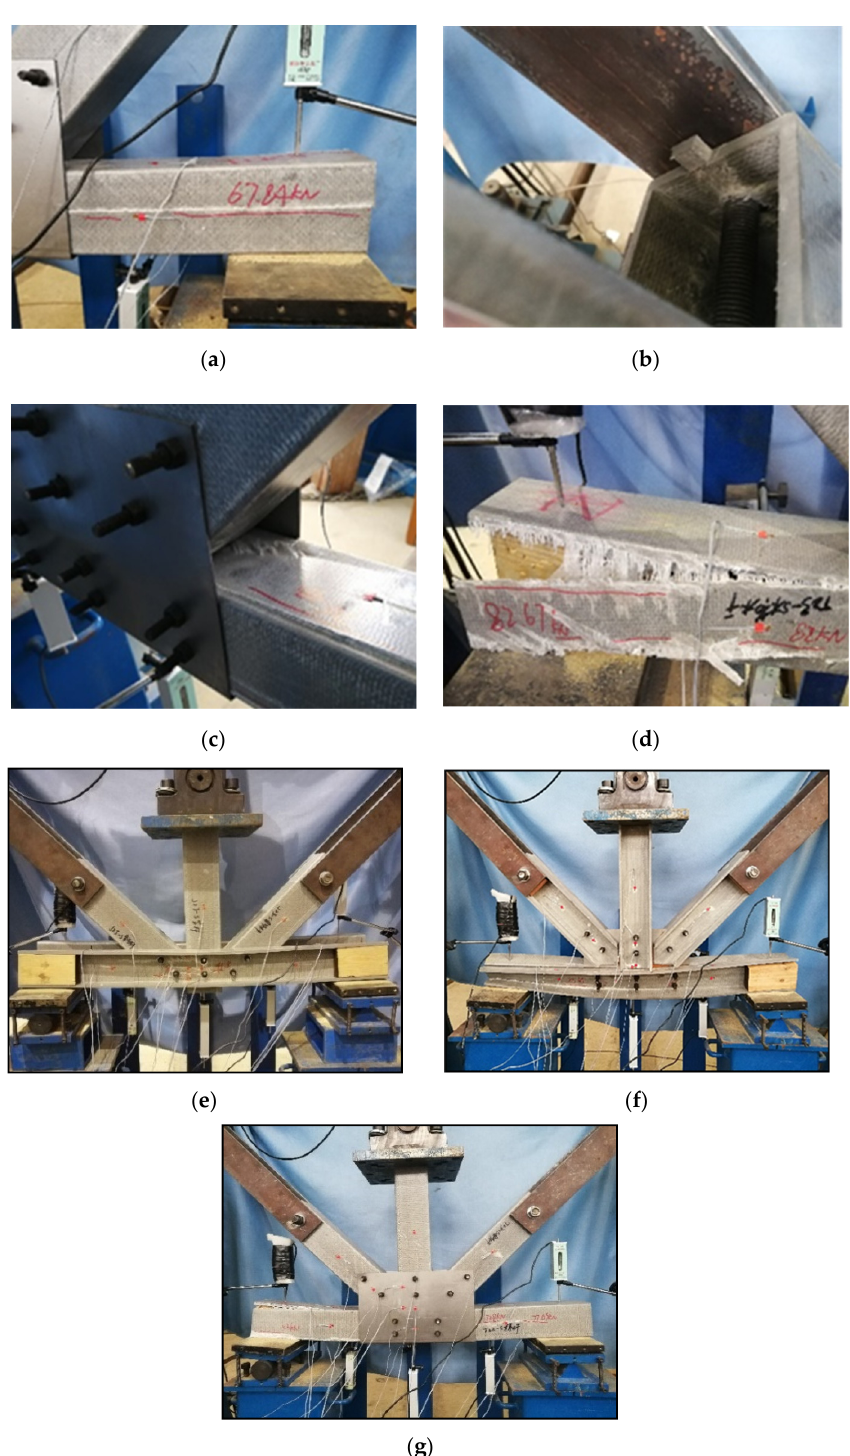
Figure 18. Failure modes of GFRP truss joints: ( a ) shear-out of webs, ( b ) shear-out of diagonal chords, ( c ) crush of top flanges, ( d ) separation of top flange and webs, ( e ) failed specimen BJ, ( f ) failed specimen GP, and ( g ) failed specimen IGP .